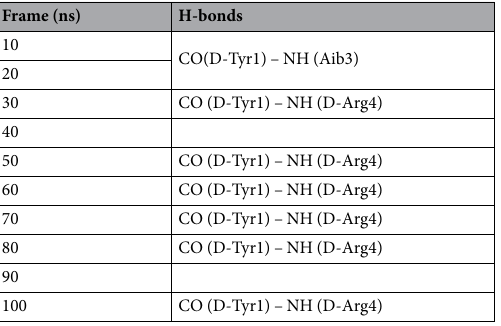
Table 2. MD simulation on RI-3: H-bonds between the